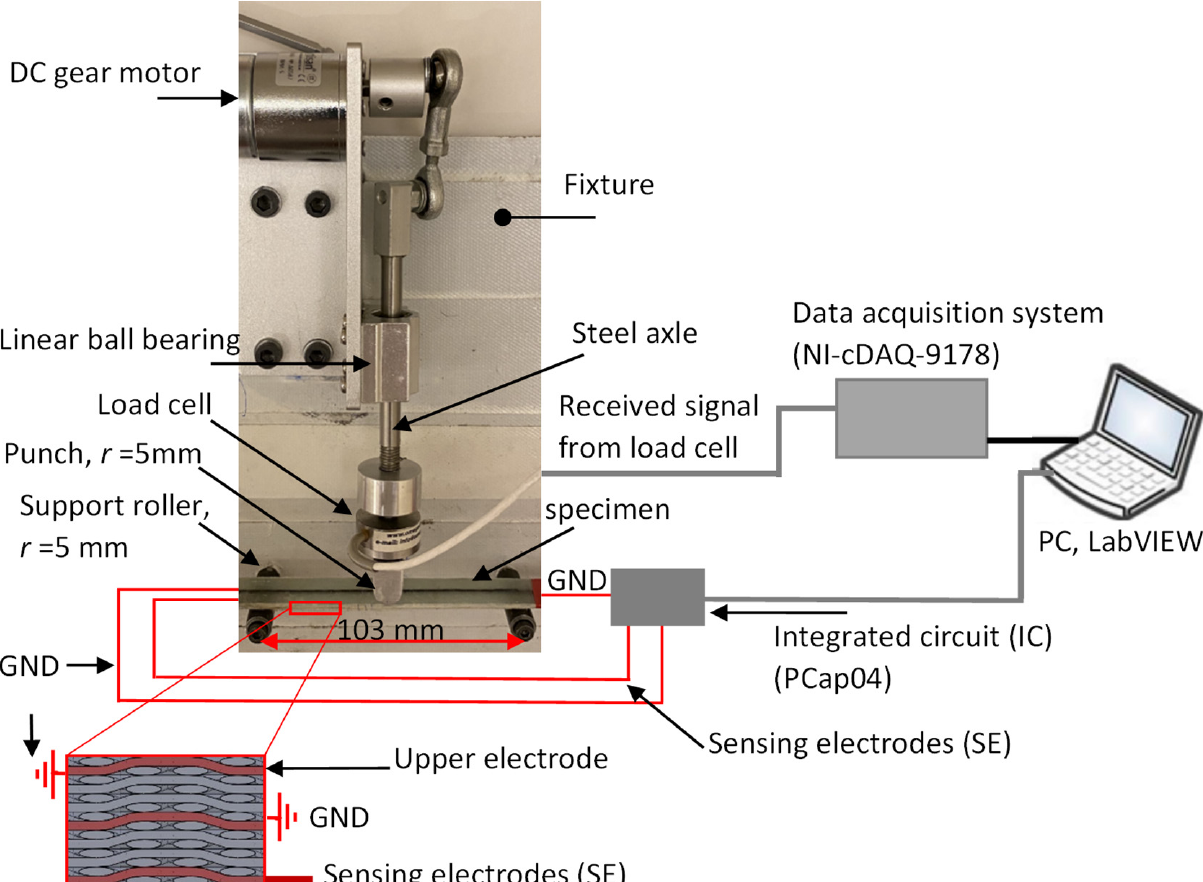
Figure 6. Configuration and experimental setup of the cyclic three-point bending test.